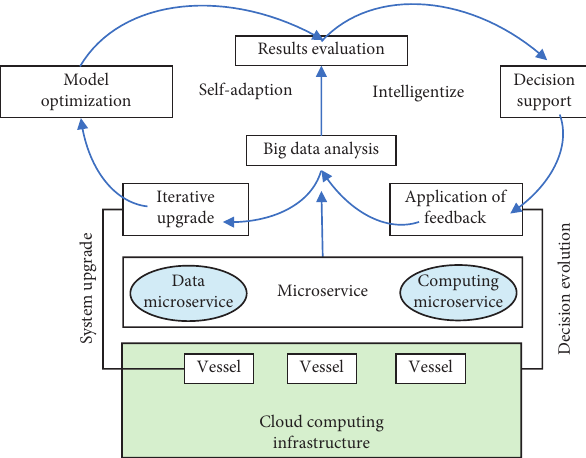
Figure 2: Knowledge discovery process in data